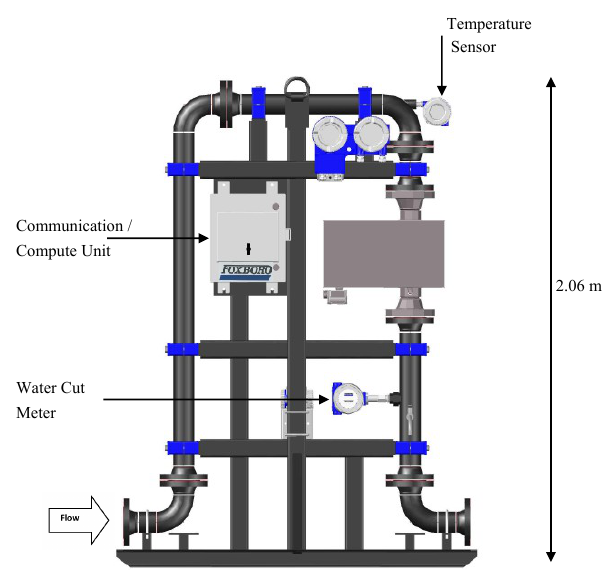
Figure 2. Net Oil and Gas